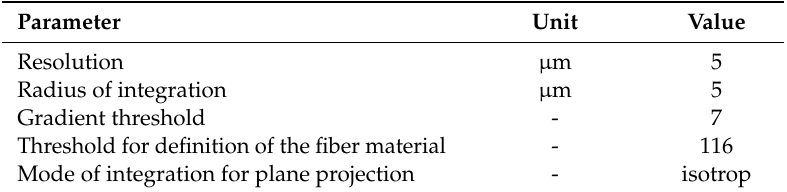
Table 5. Analysis parameters VGSTUDIO MAX 3.3.0 64 Bit.